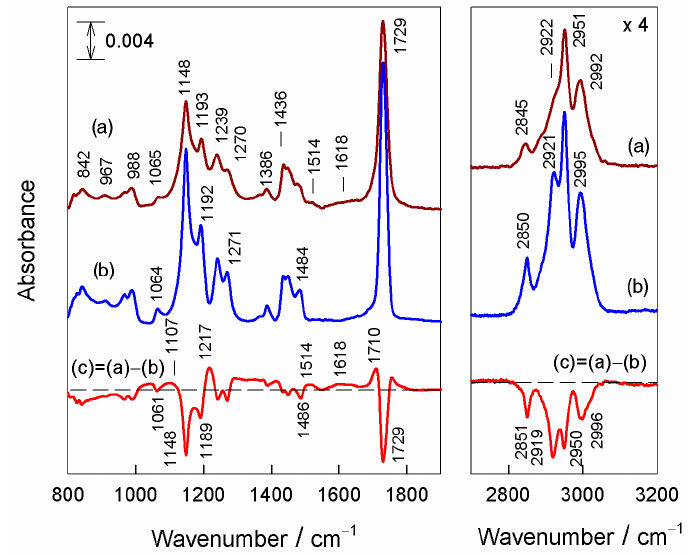
Figure 2. Transmission FTIR spectra of (a) DUV-irradiated PMMA/CaF 2 sample and (b) pristine PMMA/CaF 2 sample. The difference of the two spectra is shown as (c). Spectra are shifted vertically for clarity.